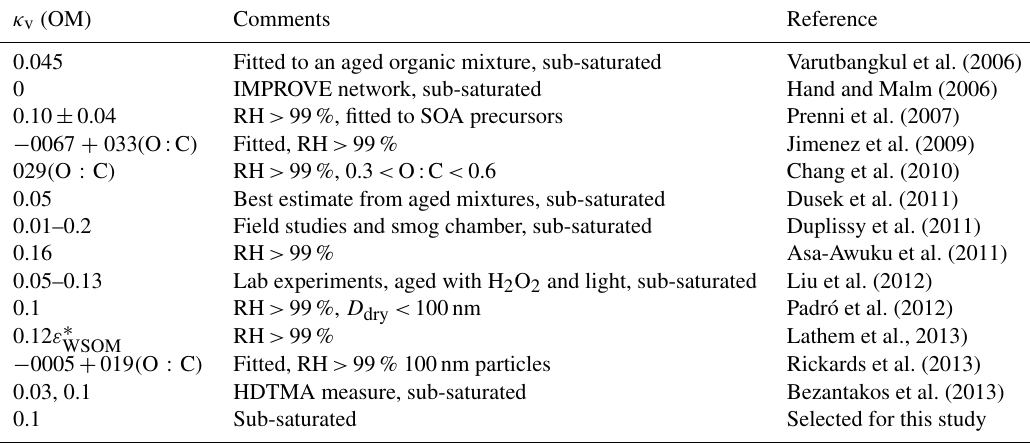
Table A1. Hygroscopicity parameter κ v for various studies on organic